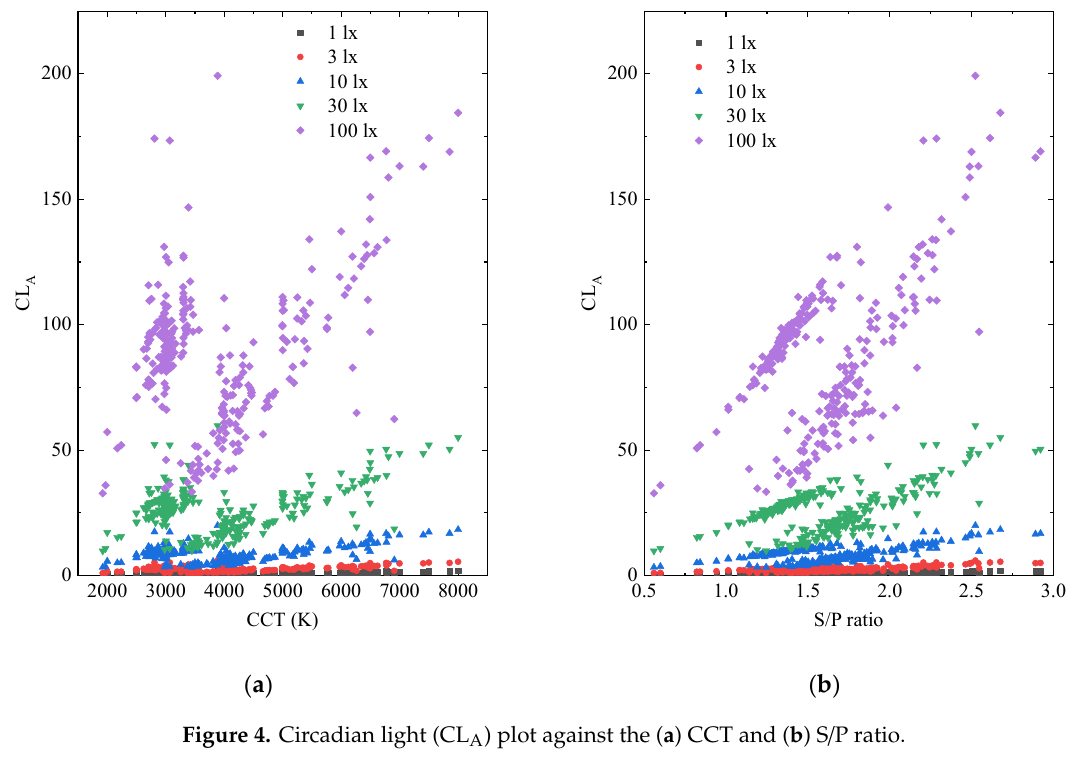
Figure 4. Circadian light (CL A ) plot against the ( a ) CCT and ( b ) S / P ratio.